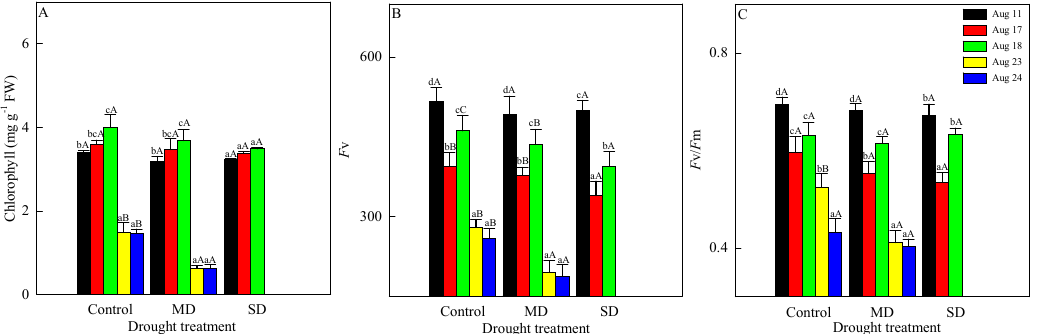
Figure 1. Changes in ( A ) leaf chlorophyll, ( B ) variable chlorophyll fluorescence ( F v), and ( C ) quantum efficiency of photosystem II ( F v/ F m) of A. halodendron under drought and rehydration phase. Values represent mean ± SE. Bars labelled with different lowercase letters represent significant differences among days for a given treatment. Bars labelled with different capital letters differ significantly among drought treatments on a given day. 11, 17 and 23 August 2018 correspond to drought, 18 and 24 August 2018 correspond to rehydration.